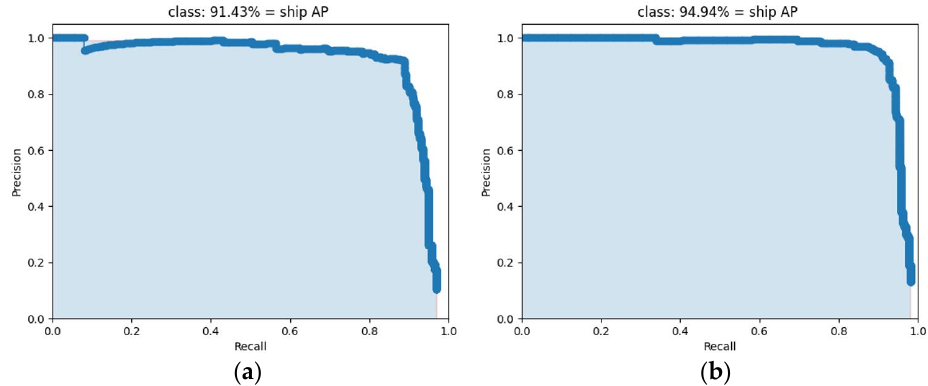
Figure 14. Comparison of the P–R curves of the two detection algorithms on HRSID: ( a ) P-R curve of YOLO V5 on HRSID dataset; ( b ) P-R curve of FLNet on HRSID dataset.